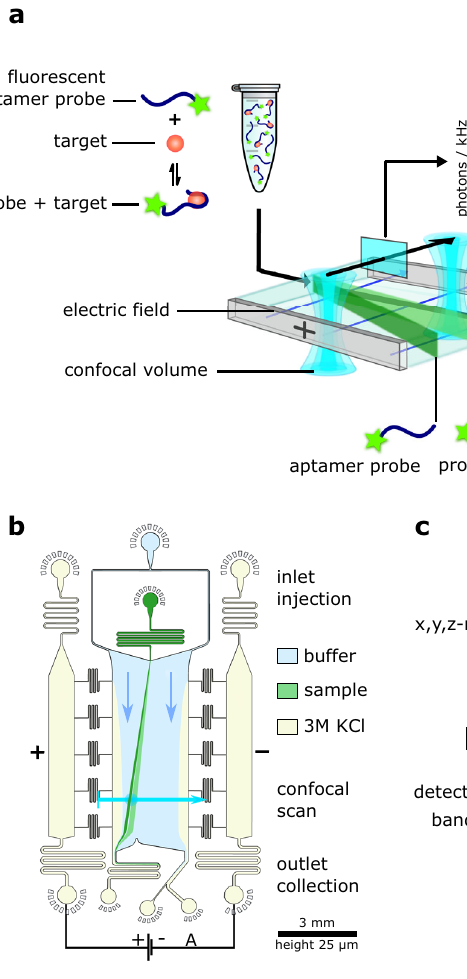
Fig. 1 | Working principle of DigitISA and its implementation. a Schematic illustration of the DigitISA platform and overview of the experimental work fl ow. DigitISA integrates electrophoretic separation and single-molecule detection in a platform for single-step sensing of target proteins in solution using only a single af fi nity reagent. The sample including a mixture of the target protein and its fl uorescently labeled af fi nity probe (e.g., aptamer) is injected into a micron-scale electrophoretic separation unit. The application of an electric fi eld allows protein- bound probe molecules to be discriminated from those probe molecules that are not bound to the protein target, owing to a difference in their electrophoretic mobilities. Confocalscanning across the separationchamber isperformed and the number of molecules traversing the confocal volume at each of the scanned positionsisestimated ‘ digitally ’ fromtherecordedphoton-counttimetraceusinga combined inter-photon time (IPT) and photon-count threshold burst-search algo- rithm. From the obtained counts, an electropherogram is created allowing for a discrimination between protein-bound af fi nity probe and free probe. b Design